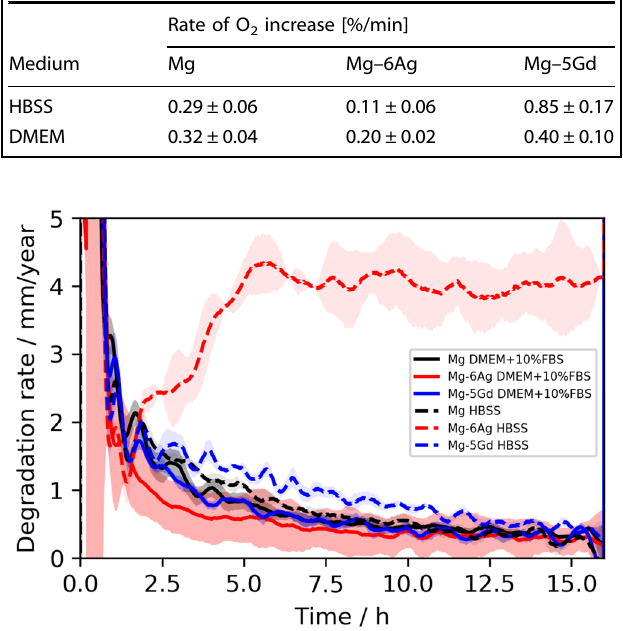
Fig. 5 Degradation rates of alloys in immersion media as obtained from pressure measurements for H 2 evolution. The average (line) and standard deviation (shaded area) of the degradation rate of Mg, Mg – 6Ag and Mg – 5Gd samples immersed in DMEM + 10% FBS (solid lines) and HBSS (dashed lines) are shown.